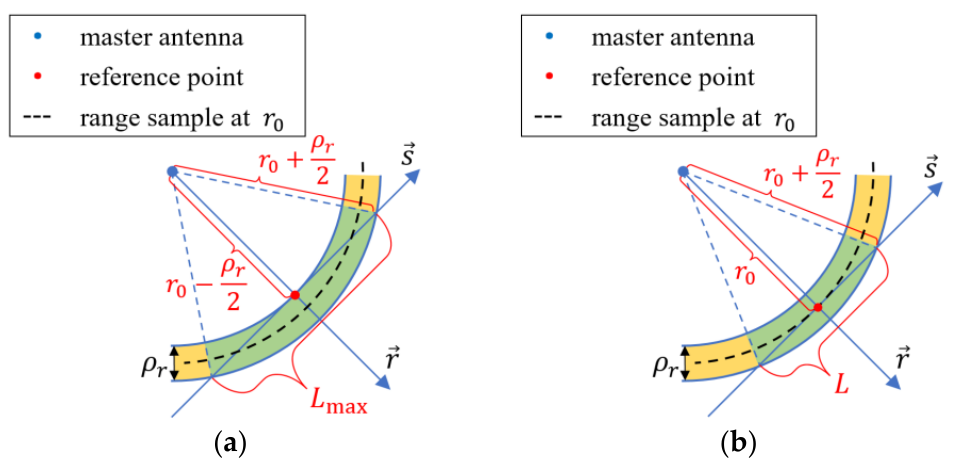
Figure 3. The effective integral interval under the planar wavefront model: ( a ) the maximum length of the effective integral interval, ( b ) the common length of the effective integral interval.